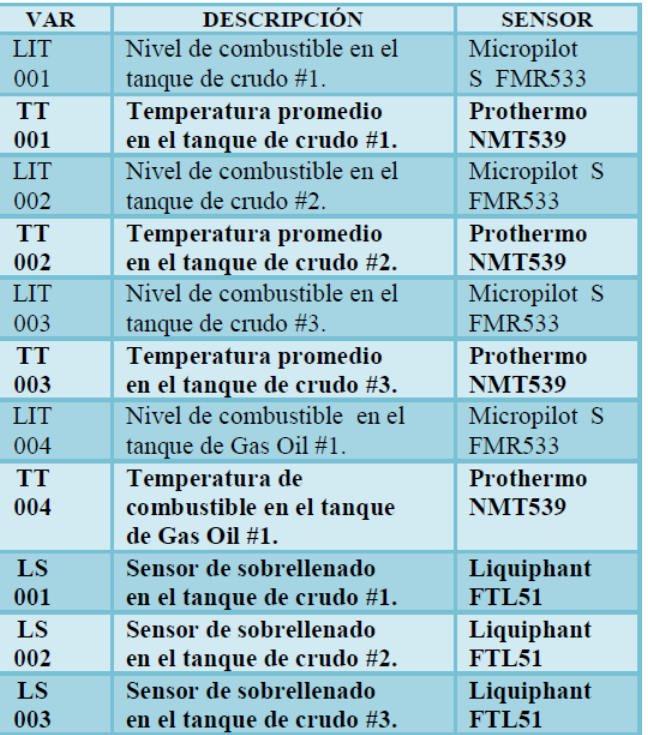
Tabla 1: Variables de tanques de almacenamiento de combustible.